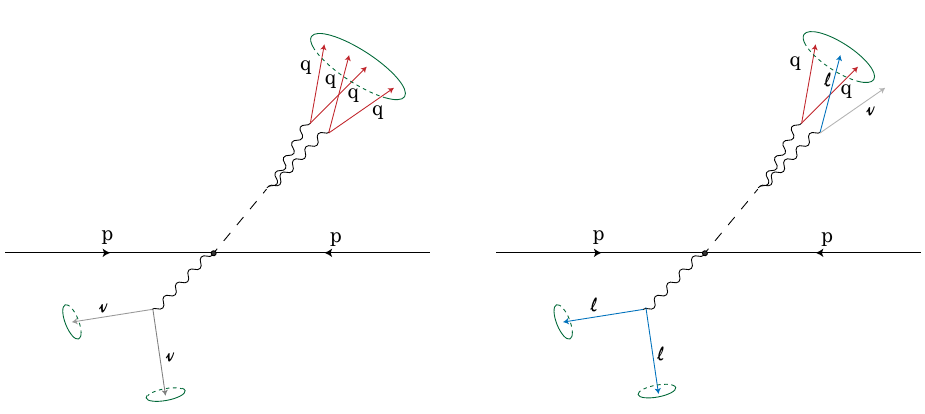
Figure 3. Considered signal processes that motivate dedicated tagging strategies. Left: a singly- produced Z 0 decays to an invisible Z and a scalar which decays further to a pair of fully hadronic W ’s. Right: a singly-produced Z 0 decays to a leptonic Z and a scalar which decays further to a pair of W ’s, one of which decays leptonically and the other